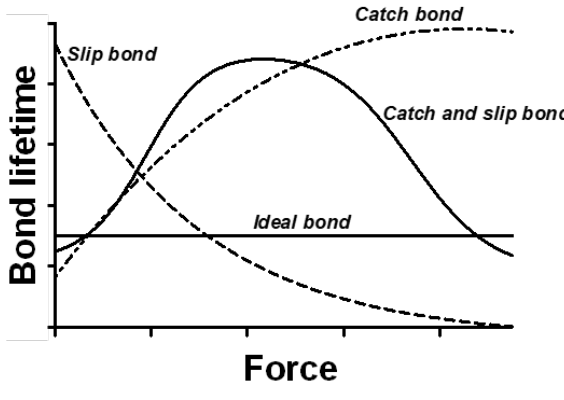
Figure 2 : Different types of bonds as a function of applied external force, according to mechanochemistry principles . The figure illustrates the mains types of bond lifetime according to the mechanochemistry theory proposed by Dembo et al. [36]: the external forces enhance the bond lifetime ( catch bond ), reduce the bond lifetime ( slip bond ), did not change the bond’s lifetime ( ideal bond ) or have a mixed effect ( catch and slip bond ).